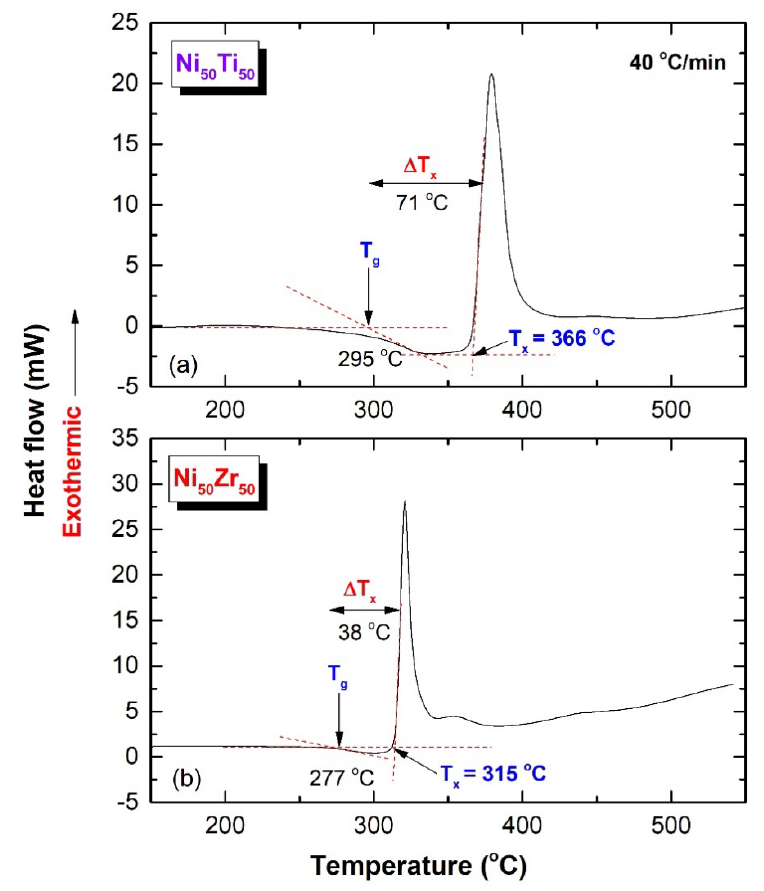
Figure 7. Differential scanning calorimetry (DSC) traces conducted at 40 °C/min for ( a ) metallic glassy Ni 50 Ti 50 and ( b ) Ni 50 Zr 50 powders obtained after 50 of MD time.